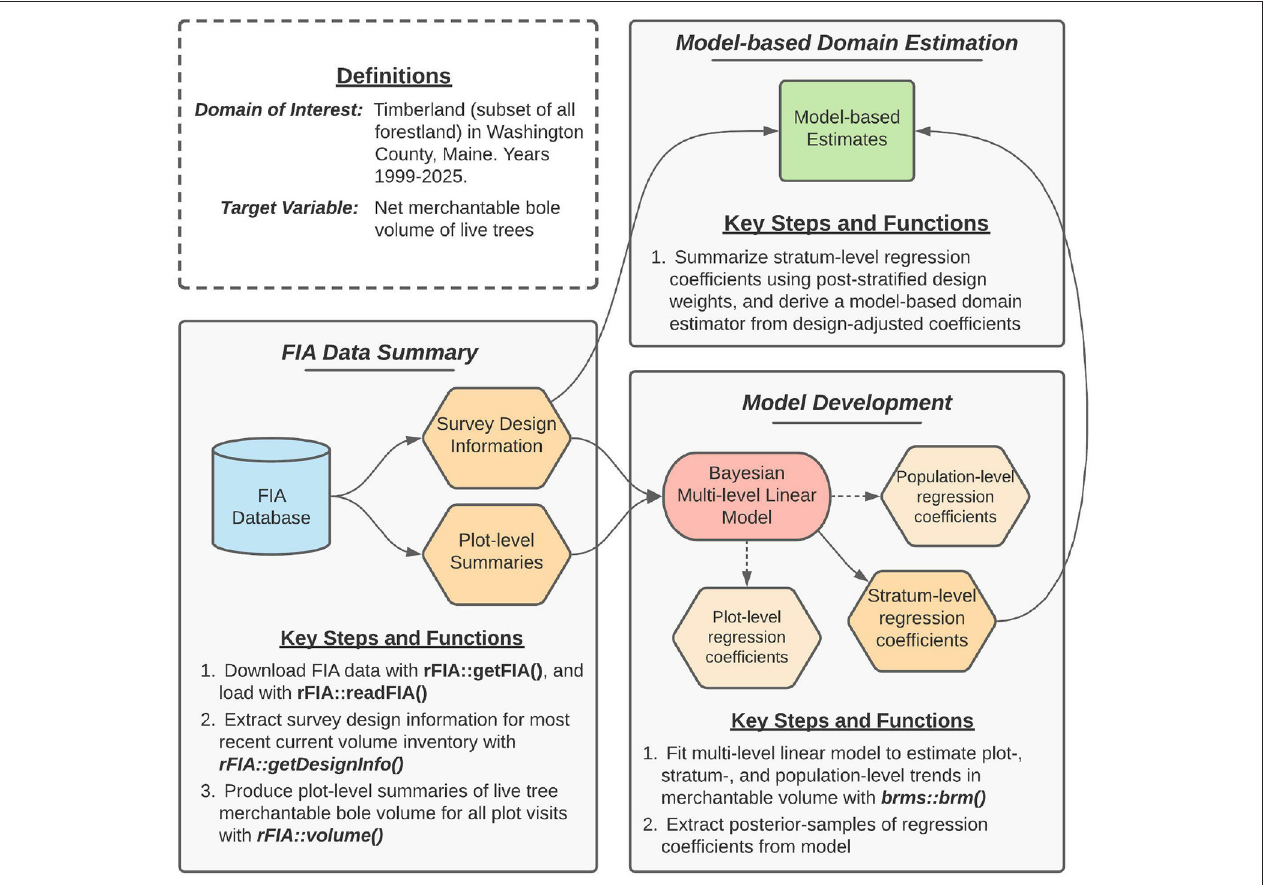
FIGURE 2 | Concept map illustrating key steps, functions, and workflows used in to estimate multi-decadal trends in merchantable wood volume in Washington County, Maine. Here, blue cylinders represent data inputs, orange hexagons represent intermediate data products, red ovals represent models, and green rectangles represent domain